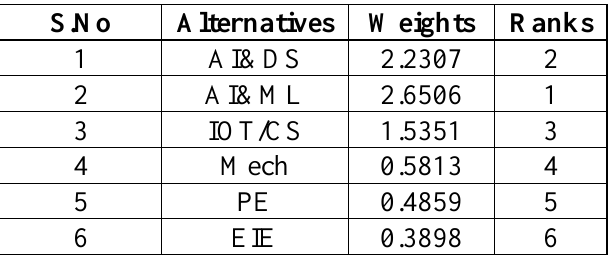
Table 13: Ranking and Weights of